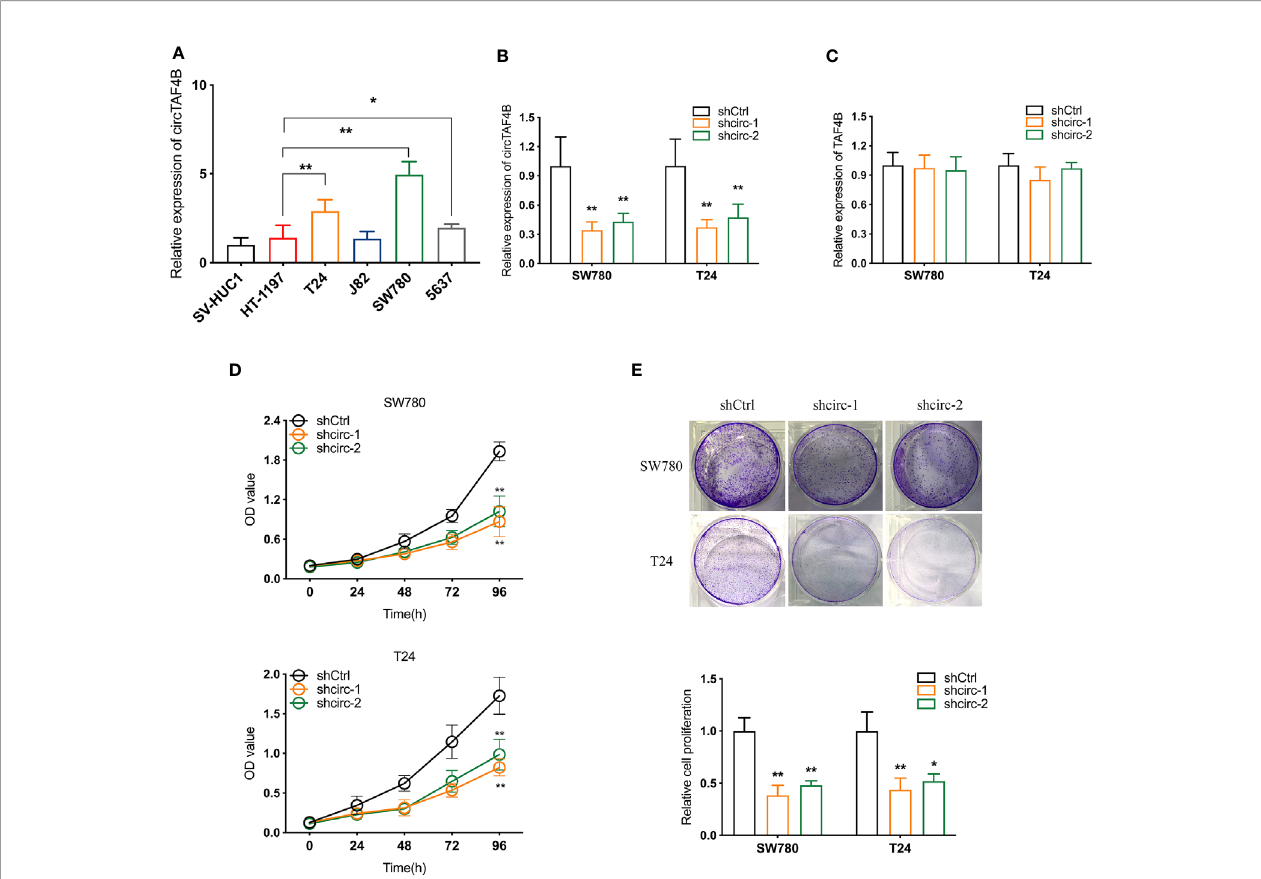
FIGURE 2 | Knockdown of circTAF4B inhibited the proliferation of BCa cells in vitro . (A) The expression level of circTAF4B in different Bca cell lines and a normal epithelial cell line. (B, C) The effect of shRNAs targeting circTAF4B (shcirc-1 and shcirc-2) on circTAF4B and TAF4B expression. (D, E) CCK-8 assay and colony- formation assay showed that transfection of circTAF4B decreased the proliferation of BCa cells. Data represent the mean ± SD of more than three independent experiments. *p < 0.05; **p <